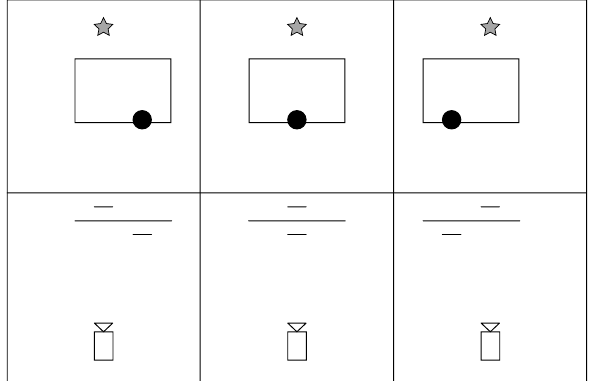
Figure 3: Sketch of parallax scrolling scene with simulated cam- era movement from left to right. Upper row: The images that the camera sees. Lower row: The camera looking at the